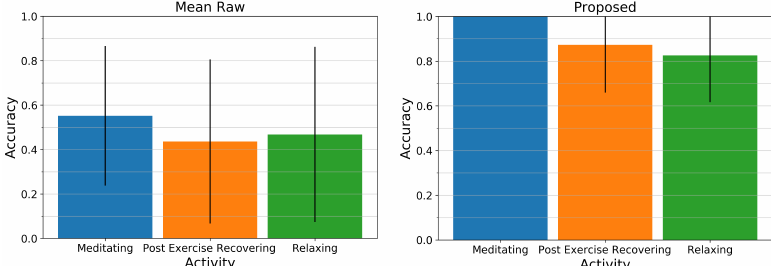
Figure 9. Comparison of two depth-based respiration estimation methods to the respiration belt. Left : The mean accuracy and standard deviation of the Mean Raw method. Right : The mean accuracy and standard deviation of our proposed